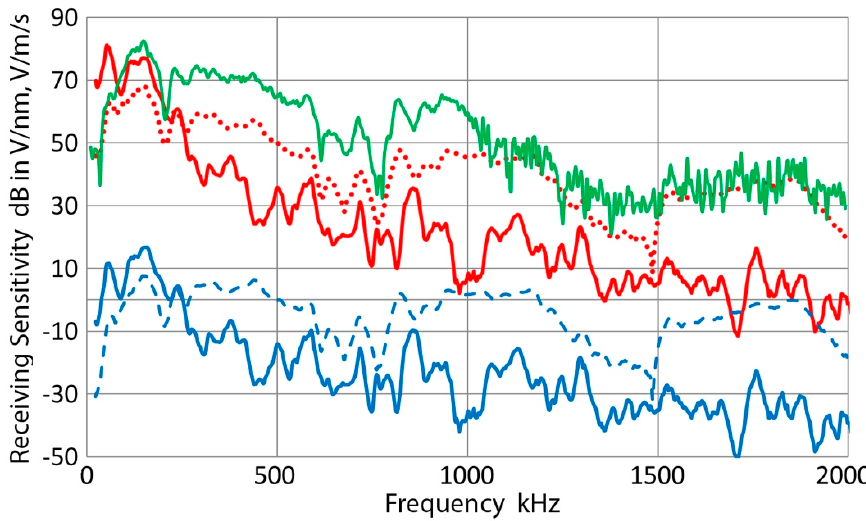
Figure 19. Receiving sensitivity of PAC R15a (BD72). The displacement receiving sensitivities are shown in blue curves and velocity sensitivities are in red. Solid lines are for the bar-wave data, while dashed curves are for the sensitivities to normally incident waves. Green curve is the velocity calibration to normally incident waves from PAC (converted from µbar to m/s unit).